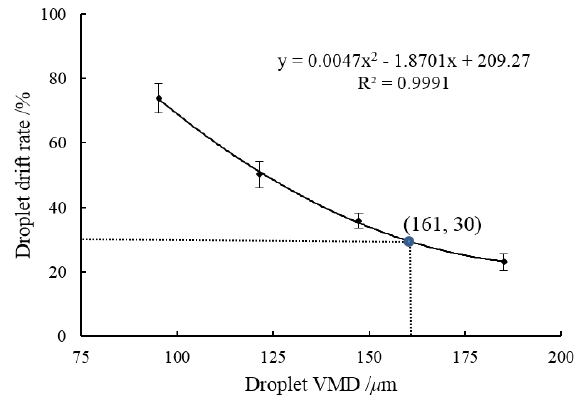
Figure 11. Regression analysis between the cumulative drift rate and the volume median diameter (VMD) of droplets.